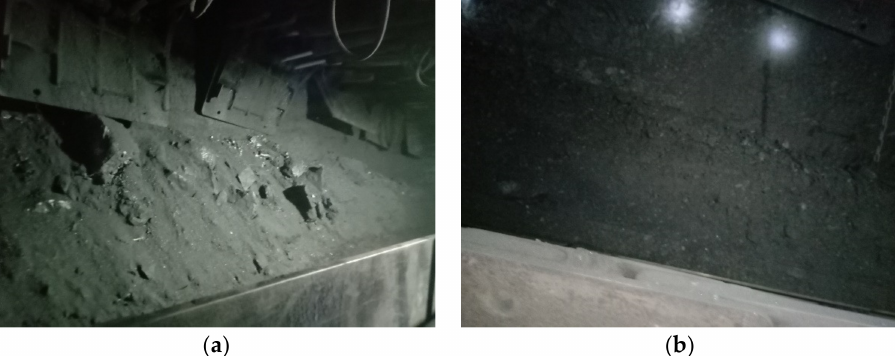
Figure 9. Comparison of roof fall before and after grouting in coal seam. ( a ) No grouting; ( b )